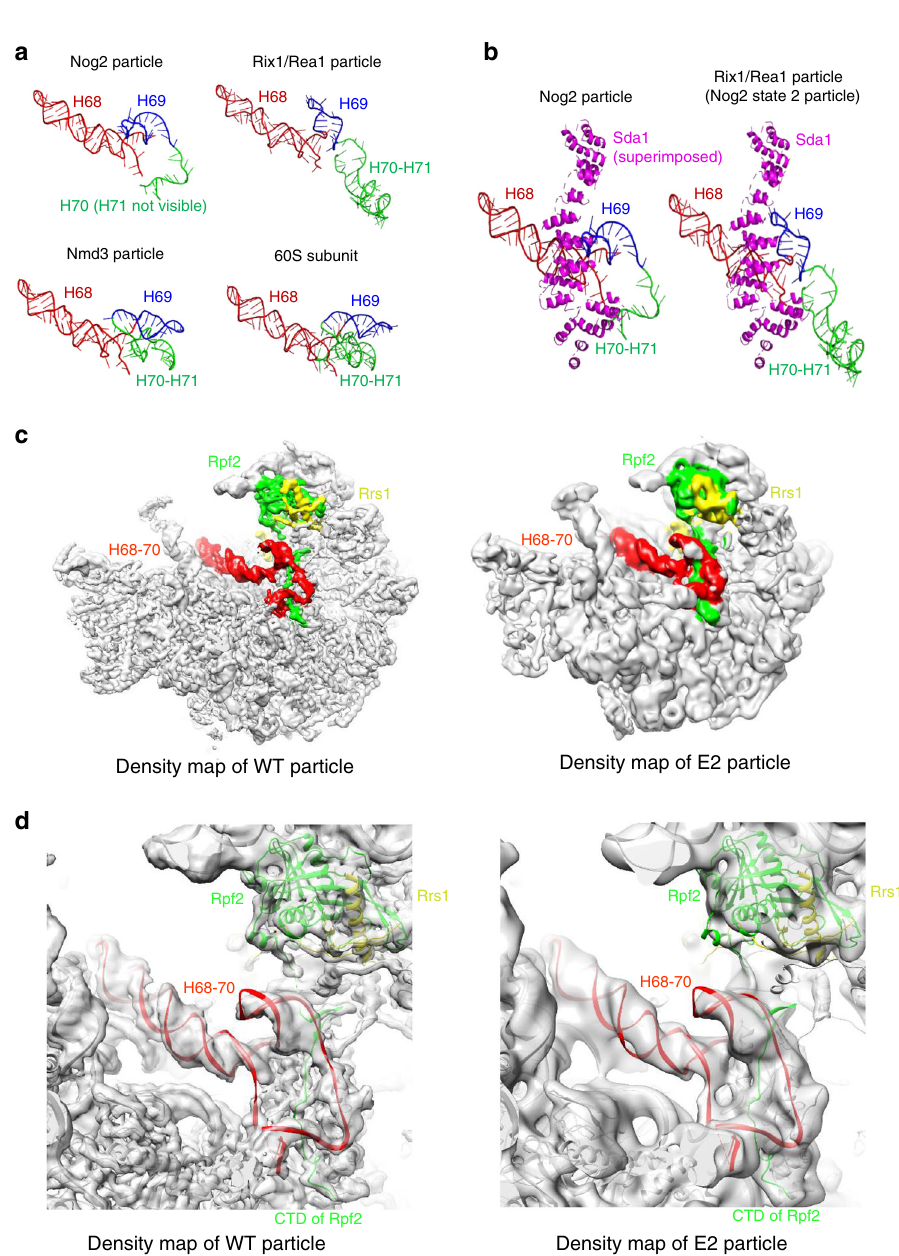
Fig. 4 Changes in H68-70 are not caused by the absence of Sda1, which binds to H68-69. a Maturation of H68-H71 in wild-type cells during the transition from Nog2 particles to Rix1/Rea1 particles, then Nmd3 particles, and fi nally to mature 60S subunits (PDB IDs 3JCT [https://www.wwpdb.org/ pdb?id = pdb_00003jct], 5FL8 [https://doi.org/10.2210/pdb5FL8/pdb], 5APN [https://doi.org/10.2210/pdb5APN/pdb], and 4V88 [https://doi.org/ 10.2210/pdb4v88/pdb]). b Left: partial structure of Sda1 from the Rix1/Rea1 (Nog2 state 2) particle superimposed onto the structure of the Nog2 particle (PDB ID 3JCT [https://www.wwpdb.org/pdb?id = pdb_00003jct]). Sda1 is in close contact with H68 and H69 of the Nog2 particle. Right: Sda1 is in close contact with H68 and H69 in the Rix1/Rea1 particle (PBD ID 5FL8 [https://doi.org/10.2210/pdb5FL8/pdb]), and the conformation of H69 is different from that in the Nog2 particle, presumably due to binding of Sda1. c Subunit interface view of density maps from the wild-type and E2 class of the Sda1-depleted particles. Densities for Rpf2, Rrs1 and H68-70 were colored using Color Zone in Chimera. No densities for H68-70 are missing in the E2 class compared with the wild-type Nog2 densities. d The atomic model for the wild-type particle was fi tted into density maps of wild-type and E2 particles, respectively. Densities for Rpf2 and H68-70 are present in particles missing